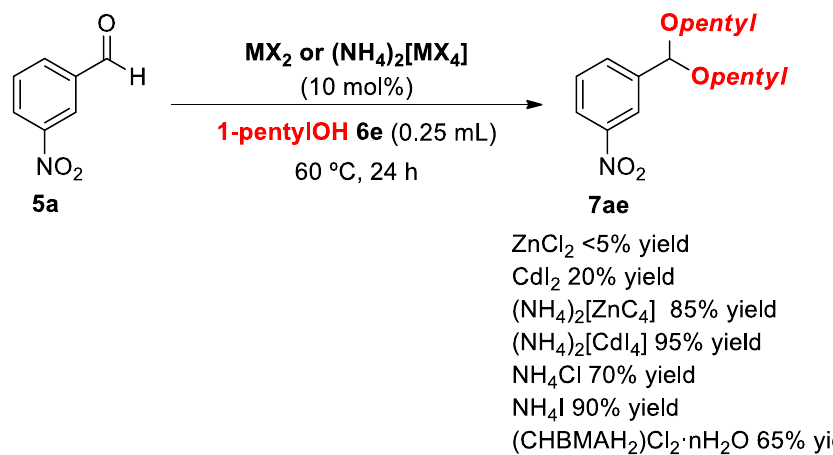
Figure 9. Scope of the reaction. Experimental conditions: a mixture of aldehydes (0.1 mmol) and catalyst (10 mol%) in 0.25 mL of n -amyl alcohol 6e was stirred at 60 °C. After 24 h, the reaction crudes were purified by column